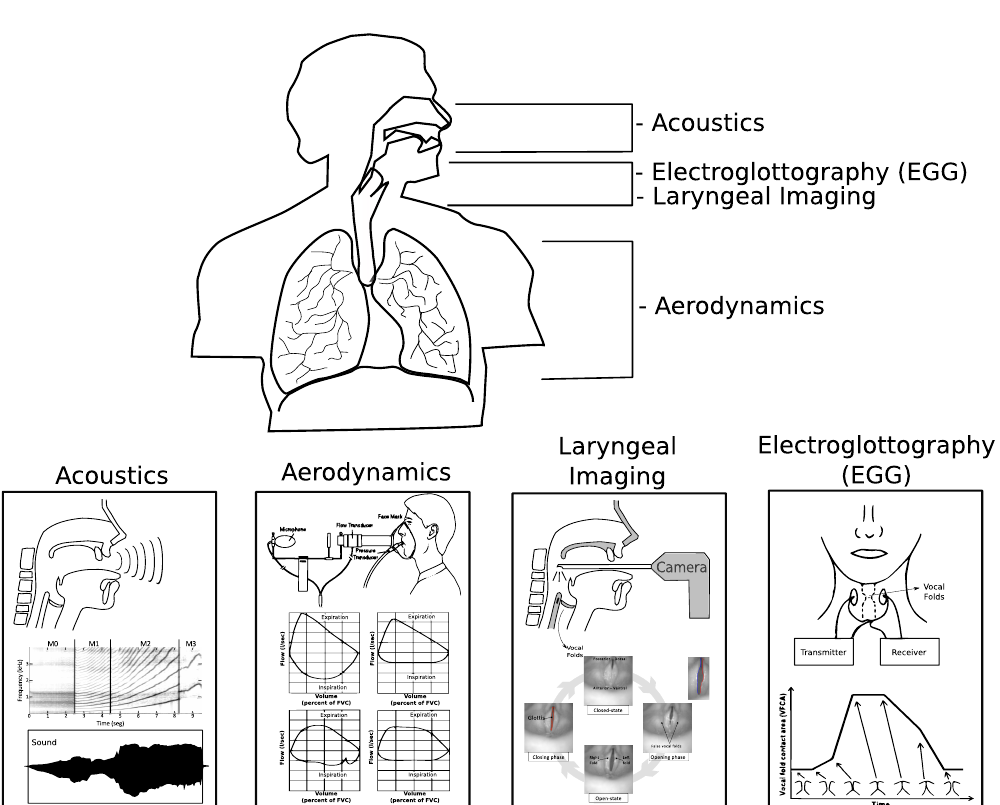
Figure 1. Sketch of different methods used for objective voice assessment. (Acoustics) Recording of the audio signal with a sonogram of an ascending vocal glissando. (Aerodynamics) Voice assessment using an air-rate meter, adapted from [9,10]. (Laryngeal Imaging) Recording of the vocal folds oscillations via a rigid endoscope. (Electroglottography) Noninvasive measurement of vocal folds contact area by electrodes applied on the surface of the neck during